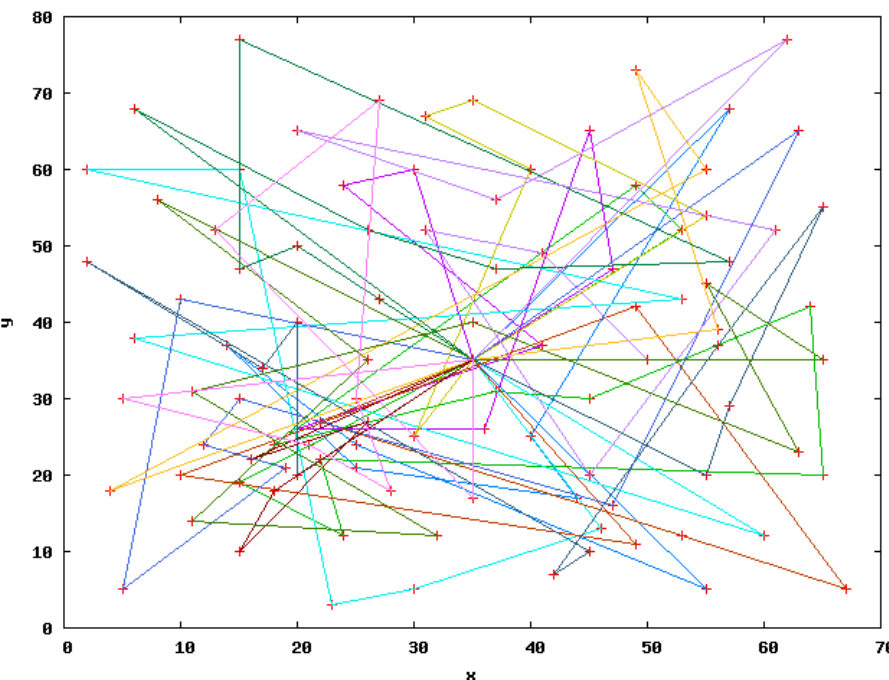
Figure 7. All combinations, moderate settings, fast experiment - example with fitness distance from the best-known one of more than